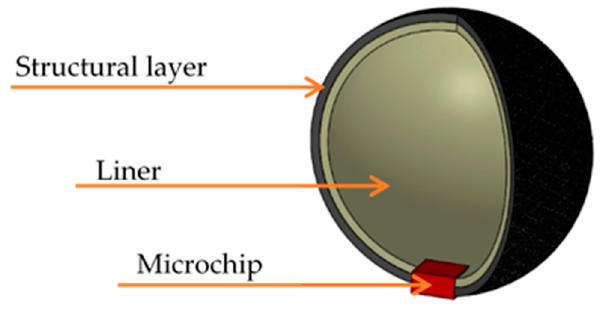
Figure 2. Sphere with microchip.